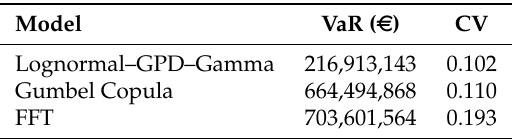
Table 11. Estimates of VaR at the 99.5% level with different models and their